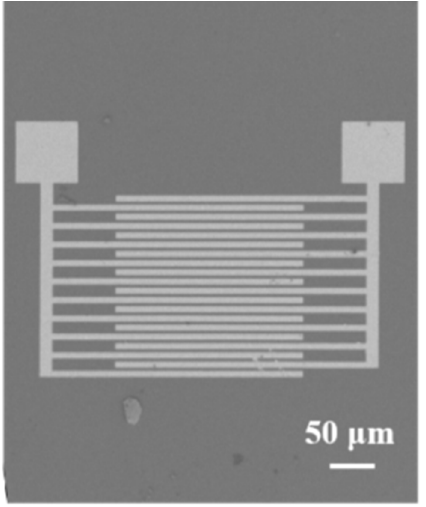
Figure 1. SEM image of the interdigitated electrode.